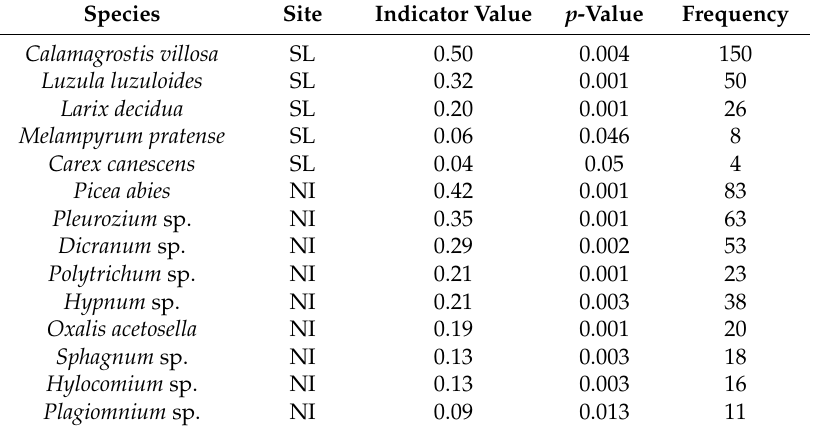
Table 2. Species significantly indicative of either SL (salvage-logged) or NI (non-intervention) site.